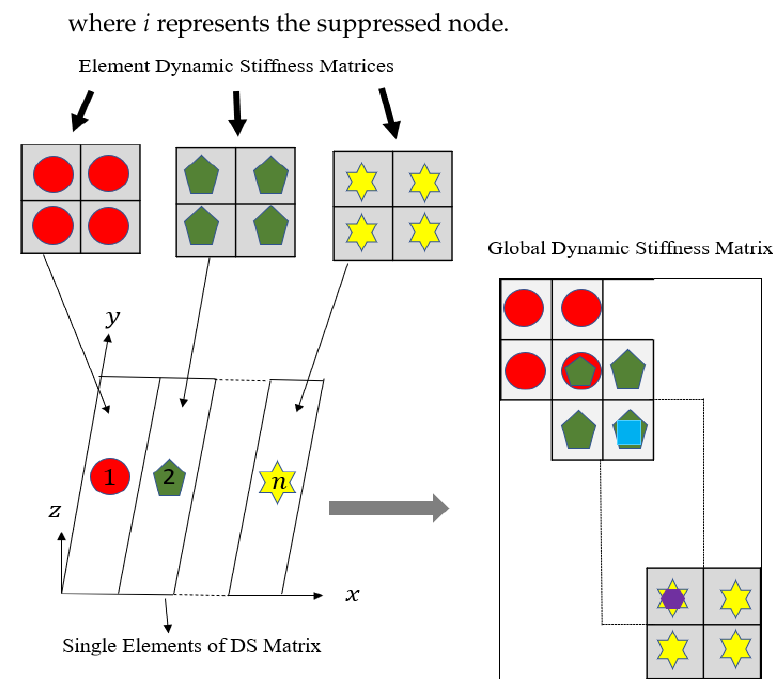
Figure 4. Assembly procedure of dynamic stiffness matrices.